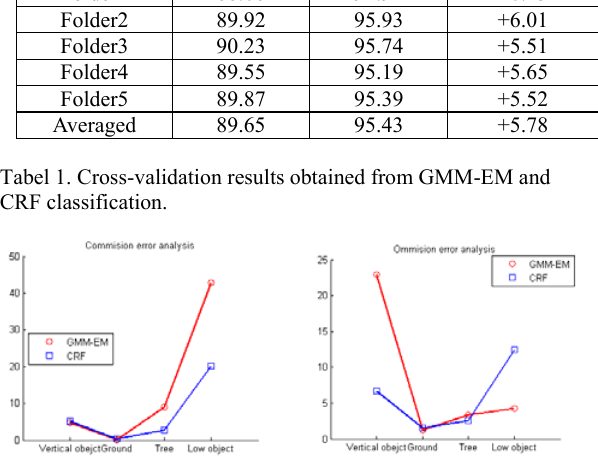
Figure 5.Per-class omission and commission errors caused by GMM-EM (left) and CRF (right).